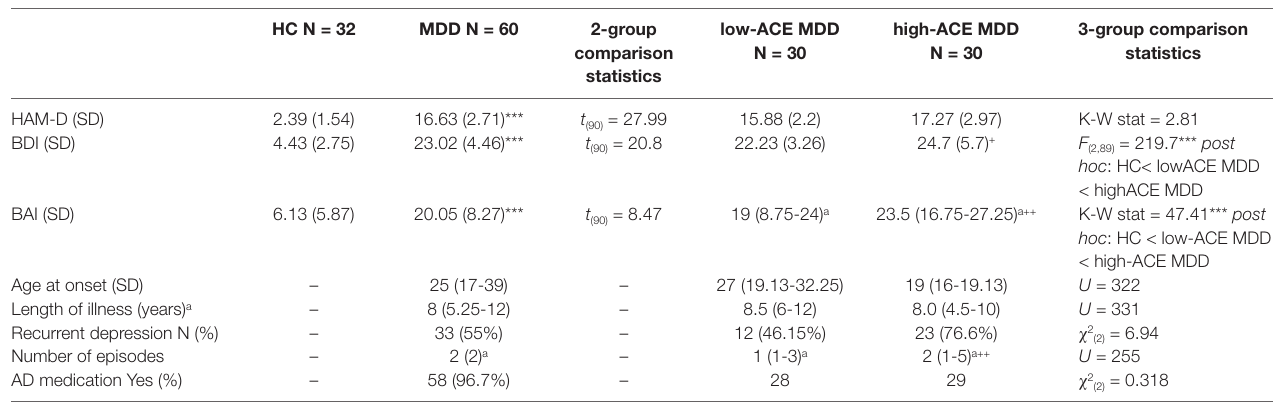
TABle 2 | Clinical variables of the sample.